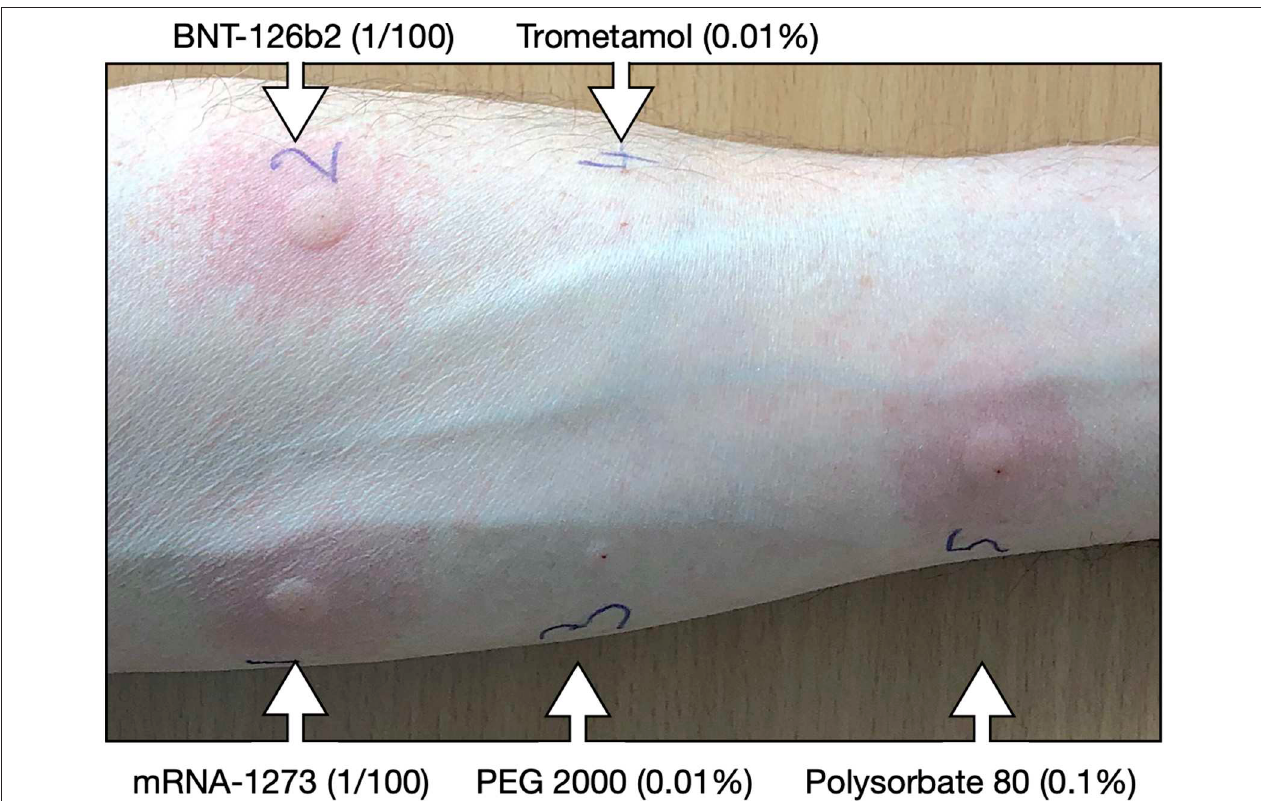
FIGURE 1 | Skin testing with COVID-19 mRNA vaccines. Representative intradermal (IDR) skin tests results of a patient with a history of laxative anaphylaxis. The picture was taken 20min after IDR for the BNT162b2 mRNA and mRNA-1273 vaccines (1/100), PEG 2000 1% (1/100), trometamol 1% (1/100). All dilutions were performed in NaCl 0.9%. PEG, polyethylene glycol; TRIS, trometamol; IDR, intradermal reaction.